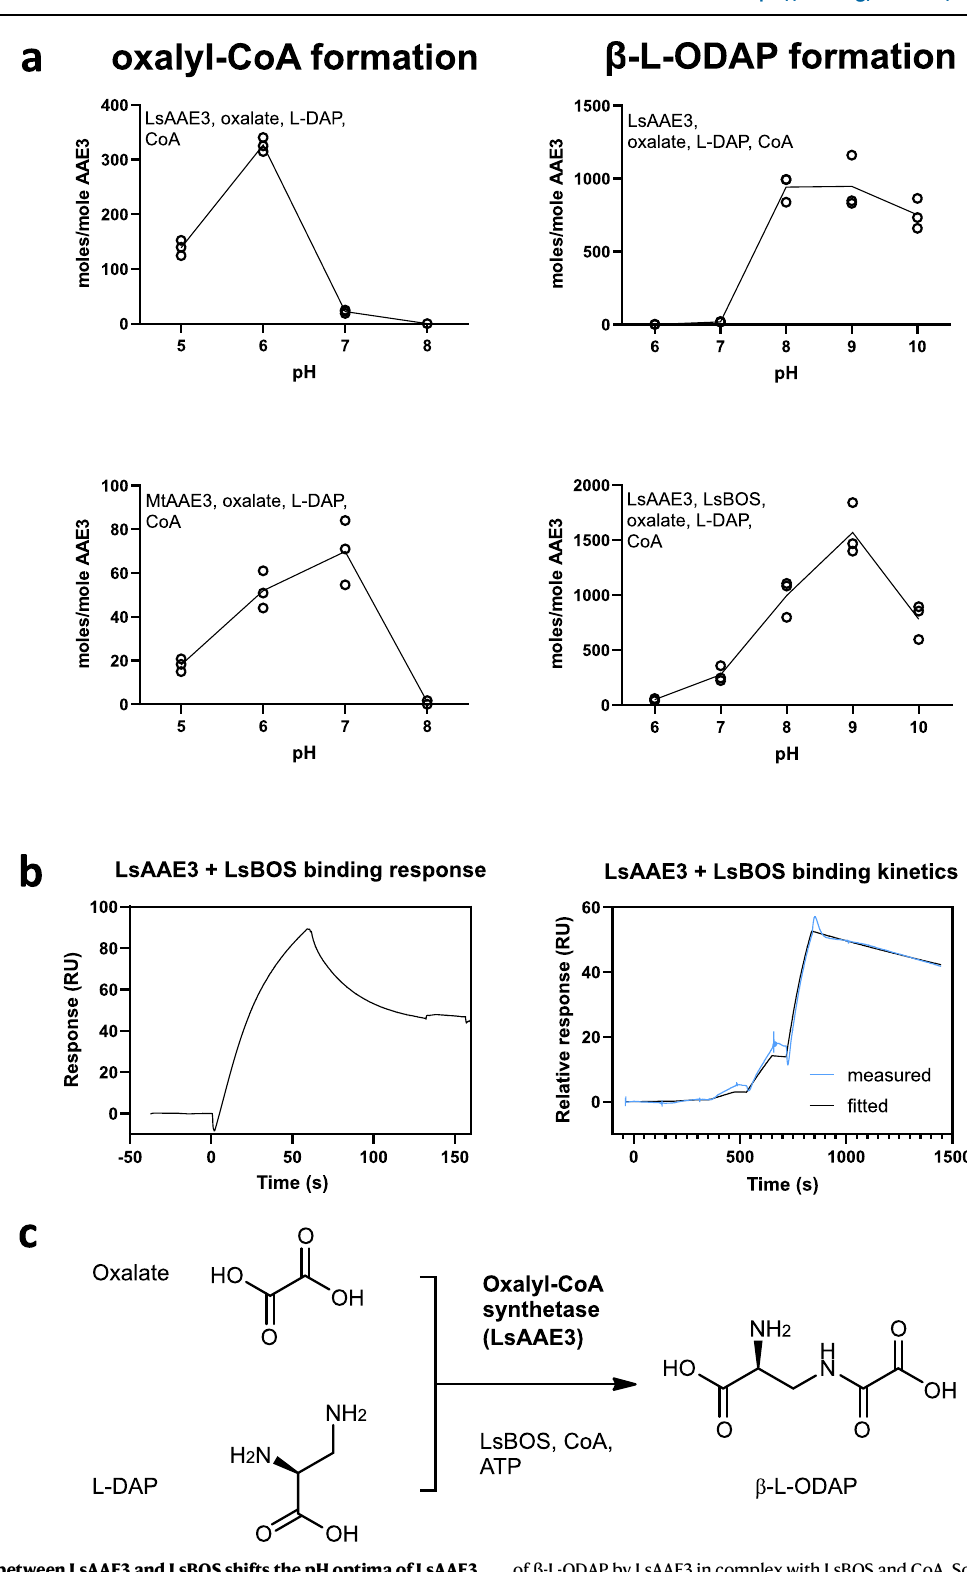
of β -L-ODAP byLsAAE3incomplexwithLsBOSandCoA.Sourcedataareprovided as a Source Data fi